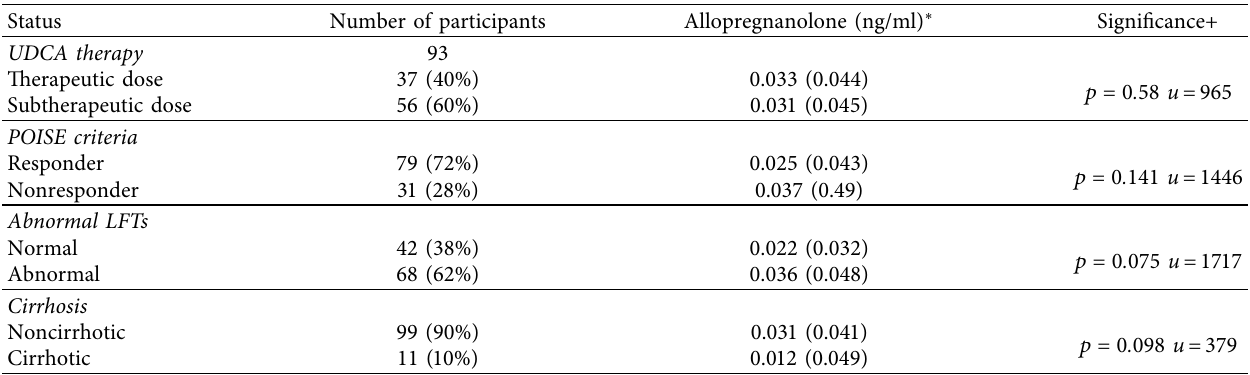
Table 4: Allopregnanolone (ng/ml) levels, by UDCA therapy, POISE criteria, liver blood tests, and